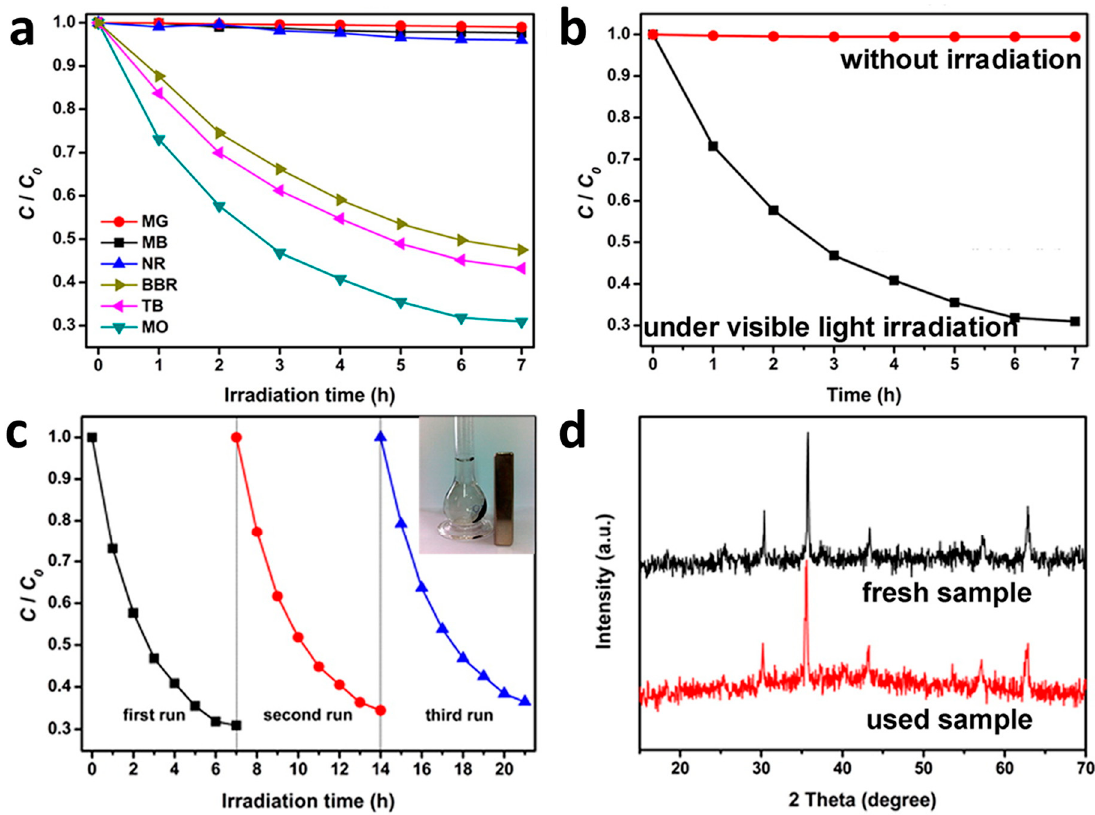
Figure 6. ( a ) Photodegradation of various dyes on TiO 2 -CoFe 2 O 4 -PANI. ( b ) Photodegradation of MO on TiO 2 -CoFe 2 O 4 -PANI without irradiation and under visible-light irradiation. ( c ) Photodegradation of MO on TiO 2 -CoFe 2 O 4 -PANI over several cycles. Inset shows the magnetic separation after photodegradation. ( d ) XRD patterns of TiO 2 -CoFe 2 O 4 -PANI before and after photocatalysis [34].